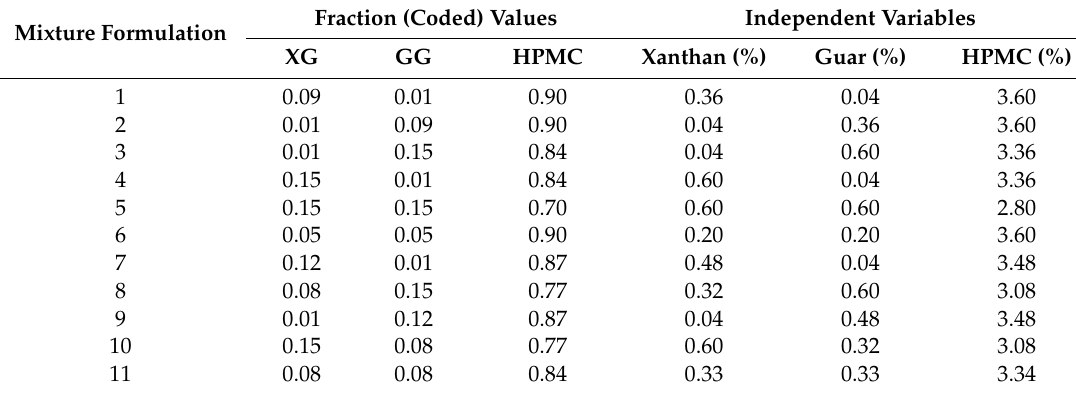
Table 1. Experimental design showing the doses of the three hydrocolloids (xanthan: XG, guar: GG and HPMC) used in the elaboration of GF